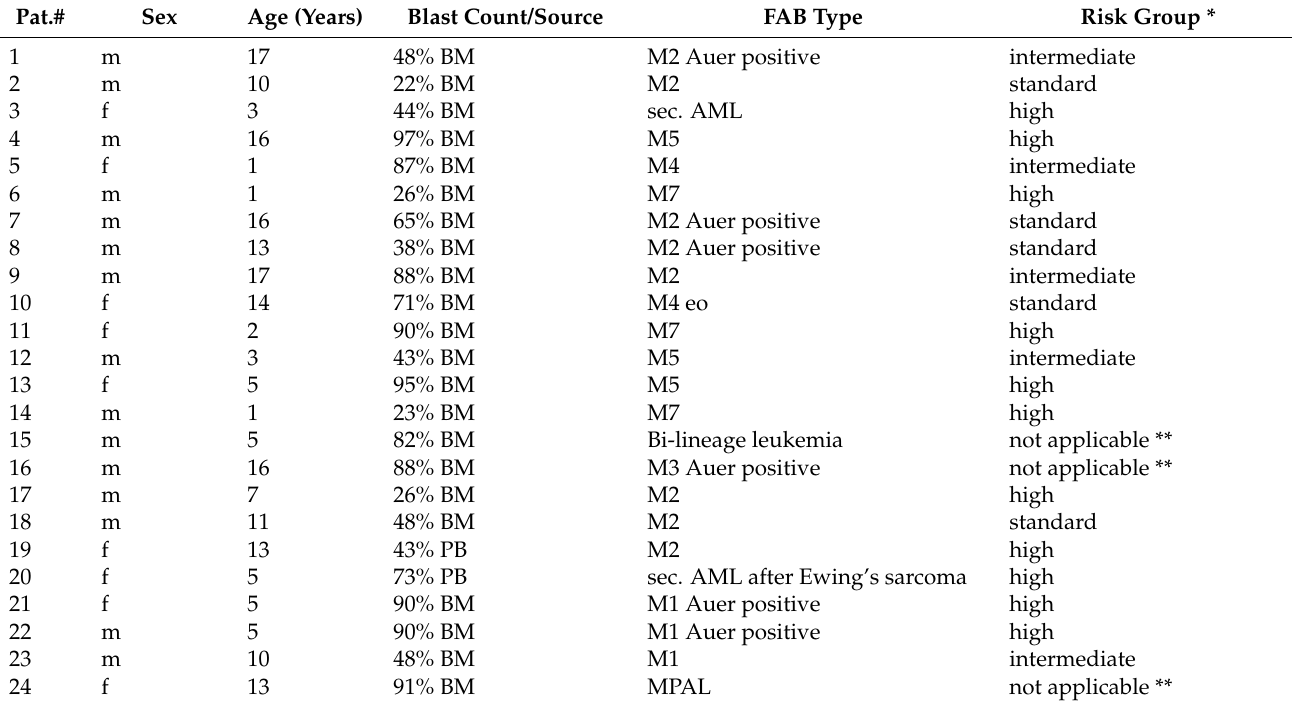
Table 1. Patient’s characteristics, proportion of leukemic blasts among nucleated cells in the sam- ple analyzed, subtype of leukemia according to the FAB classification, and resulting risk group categorized to the AML-BFM